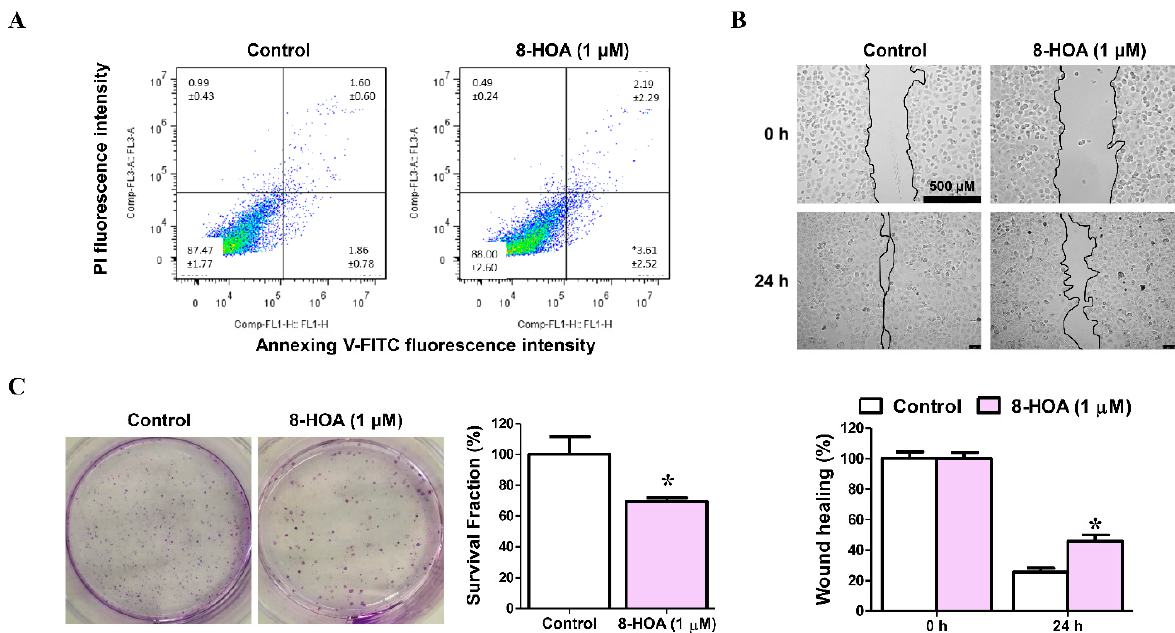
Figure 5. Effect of 8-hydroxyoctanoic acid (8-HOA) on lung cancer cell apoptosis, proliferation, and survival. ( A ) Cell apoptosis was determined by flow cytometry. ( B ) Wound-healing assay of H1299 lung cancer cells. ( C ) Colony formation assay of H1299 lung cancer. * p < 0.05 vs. Control group. Data represent mean ± SEM, unpaired t-test.